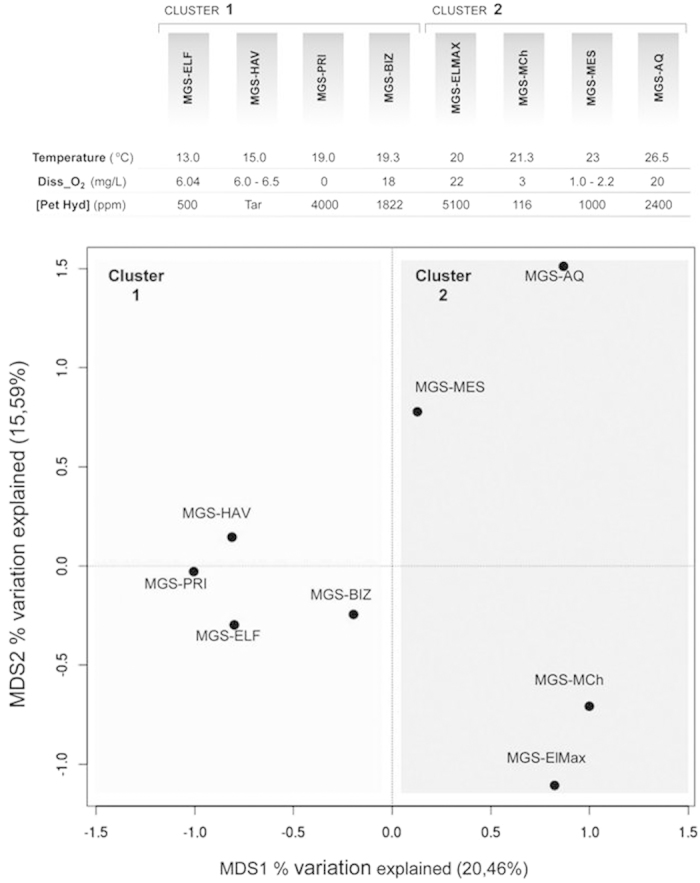
Principal coordinates analysis (PCoA) clustering Mediterranean Sea and Aqaba Gulf (Red Sea) polluted sediments according to the OTU97 composition generated from 16S rRNA gene pyrosequencing results.According to the sample distribution along MDS1, two clusters were identified through t-tests (P = 0.0017). The two clusters are indicated in the figure by light and dark grey boxes.